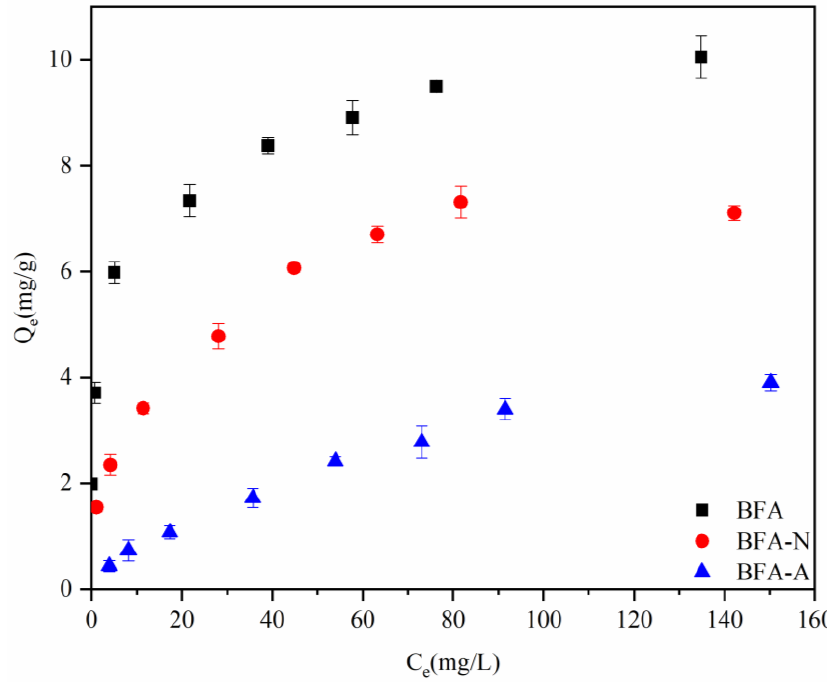
Figure 8. Isothermal adsorption curves of Cd by BFA, BFA-N, and BFA-A.